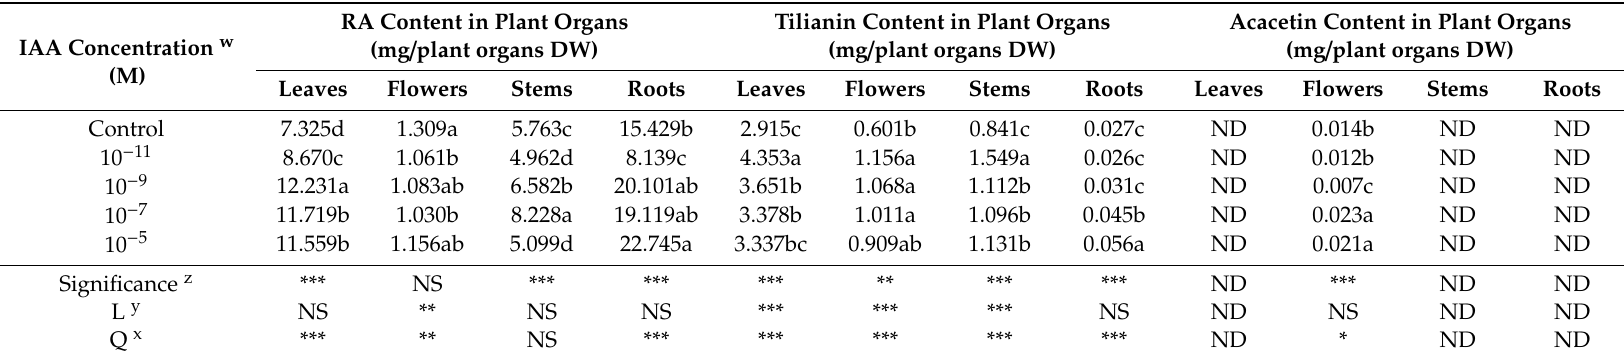
Table 3. Rosmarinic acid (RA), tilianin, and acacetin contents (mg / plant organs DW) in stems, leaves, roots, and flowers of A. rugosa subjected to the control (without IAA) and four IAA